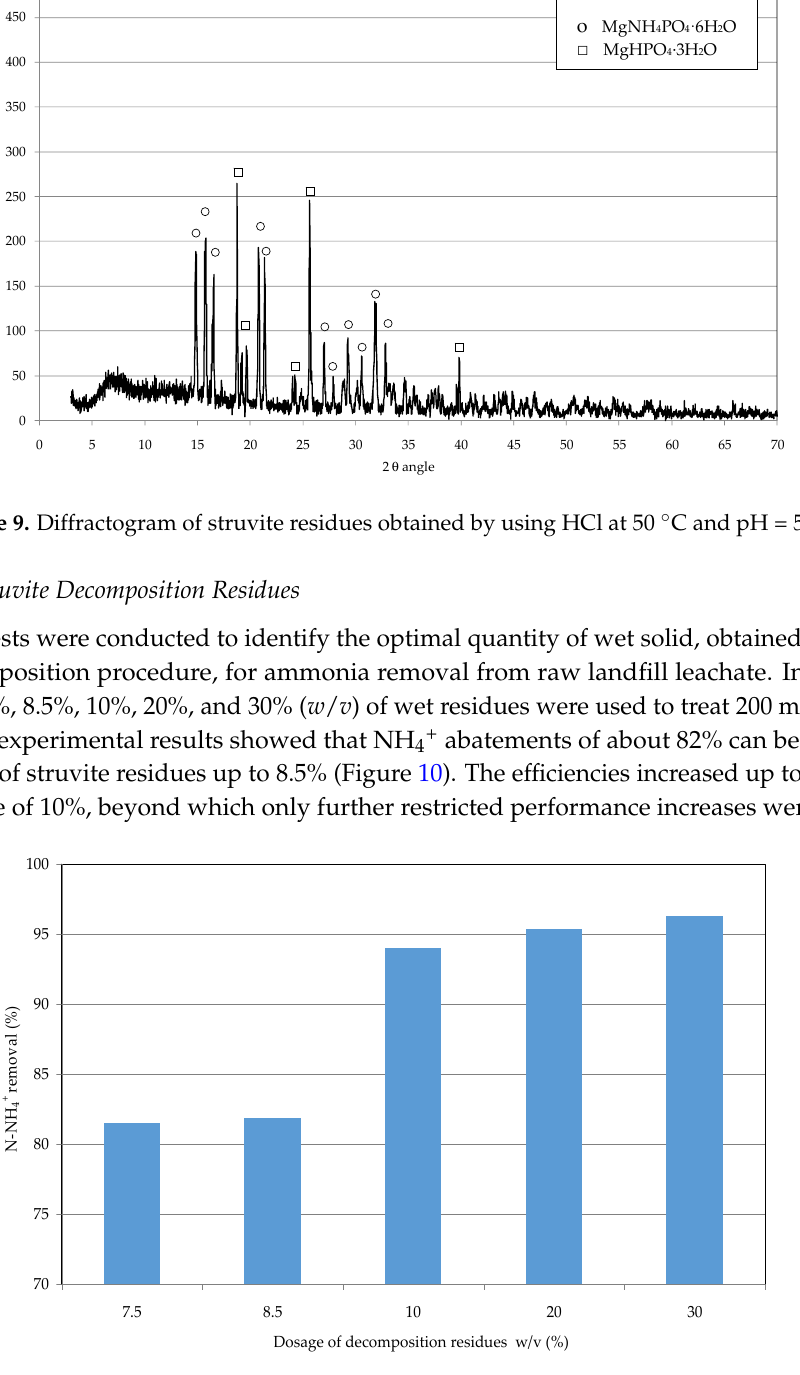
Figure 10. N-NH 4+ removal detected by changing the dosage of struvite residues for the treatment of raw leachate.